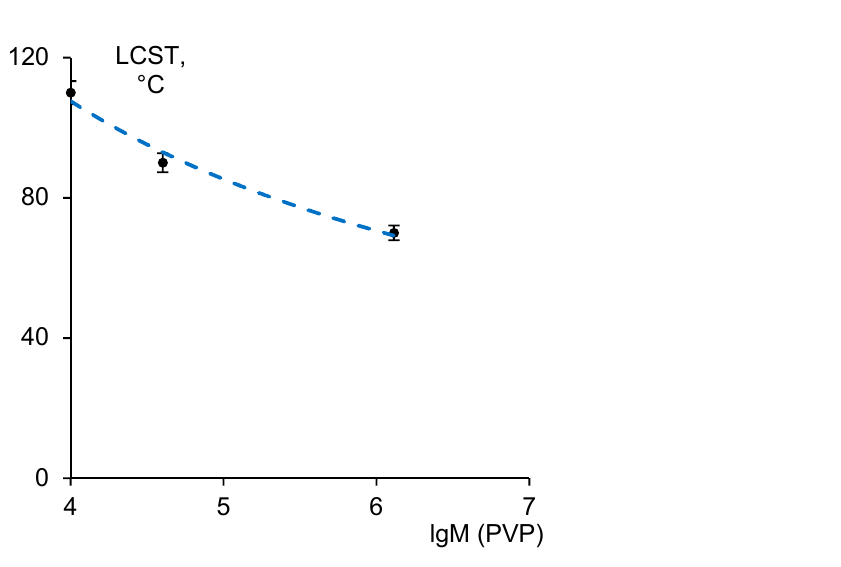
Figure 3. The dependence of LCST of the polymer solutions of 20 wt.% PSF 35 wt.% PEG-400, 0.5 wt.% PVP on PVP molecular weight.